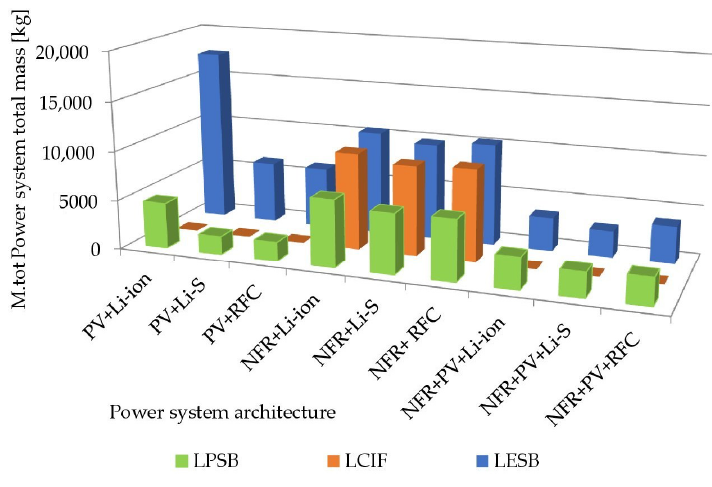
Figure 7. Total power system masses for the selected lunar base case studies.